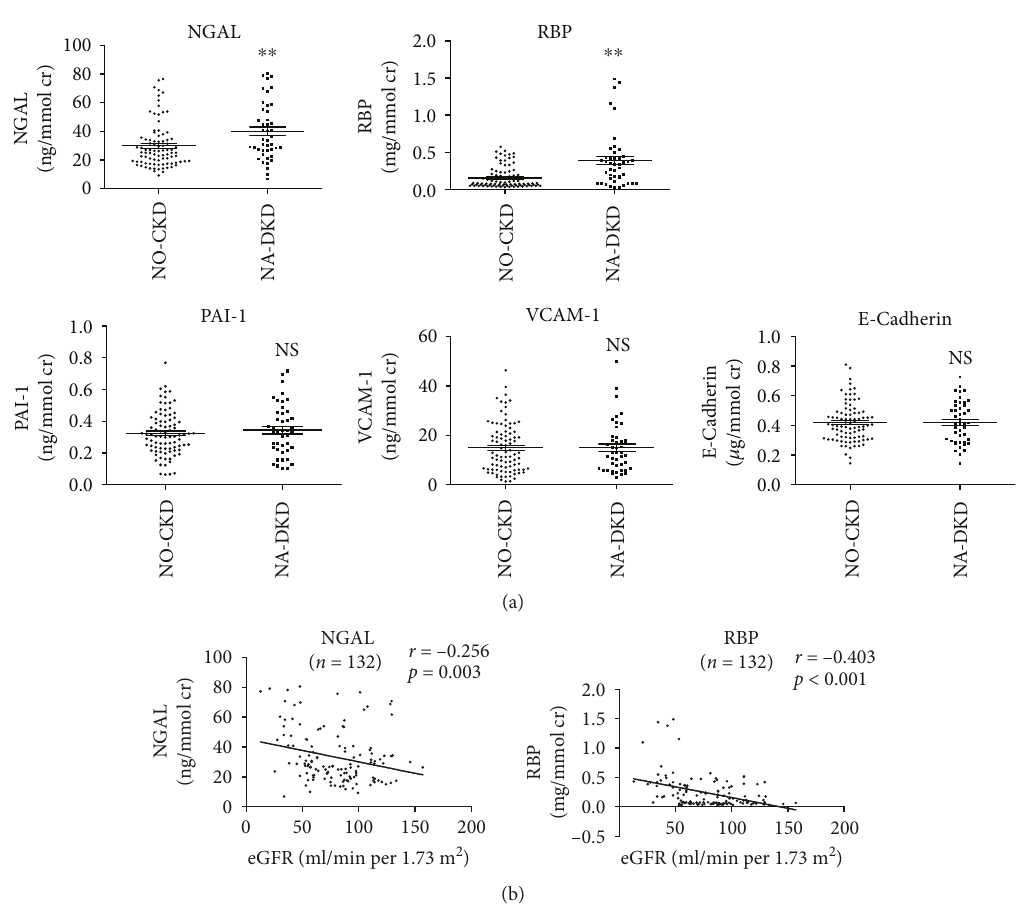
Figure 5: Correlations between urinary NGAL, RBP, PAI-1, VCAM-1, and E-cadherin with eGFR in matched T2DM patients with normoalbuminuria. (a) Levels of urinary NGAL, RBP, PAI-1, VCAM-1, and E-cadherin in matched patients with normoalbuminuria with/without renal insu ffi ciency. (b) Single linear regression analysis of urinary NGAL, RBP, and eGFR in matched T2DM patients with normoalbuminuria. ∗∗ p < 0 01 vs. the NO-CKD group. NS: no signi fi